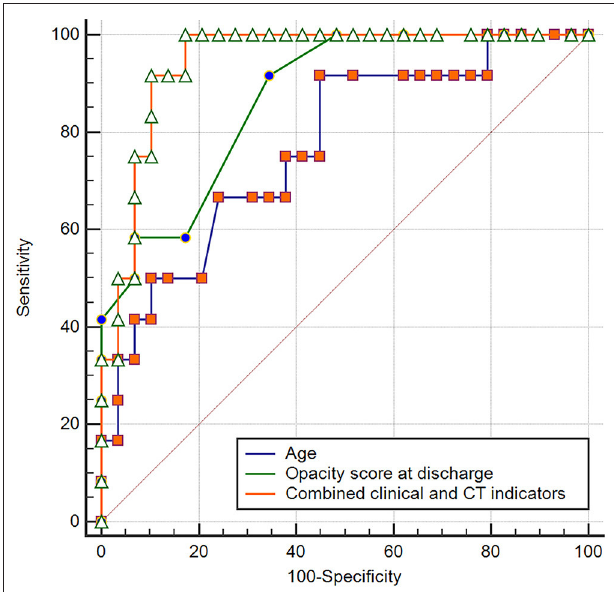
FIGURE 4 | Receiver operating curve for pulmonary fibrosis prediction in patients with COVID-19 using age or opacity score at discharge alone and combined clinical-CT indicators.